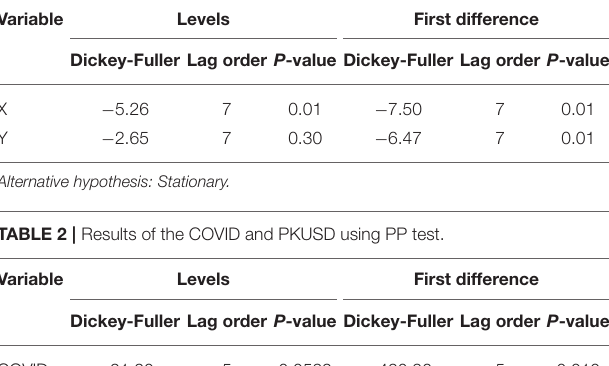
TABLE 3 | Selection criterion for VAR lag